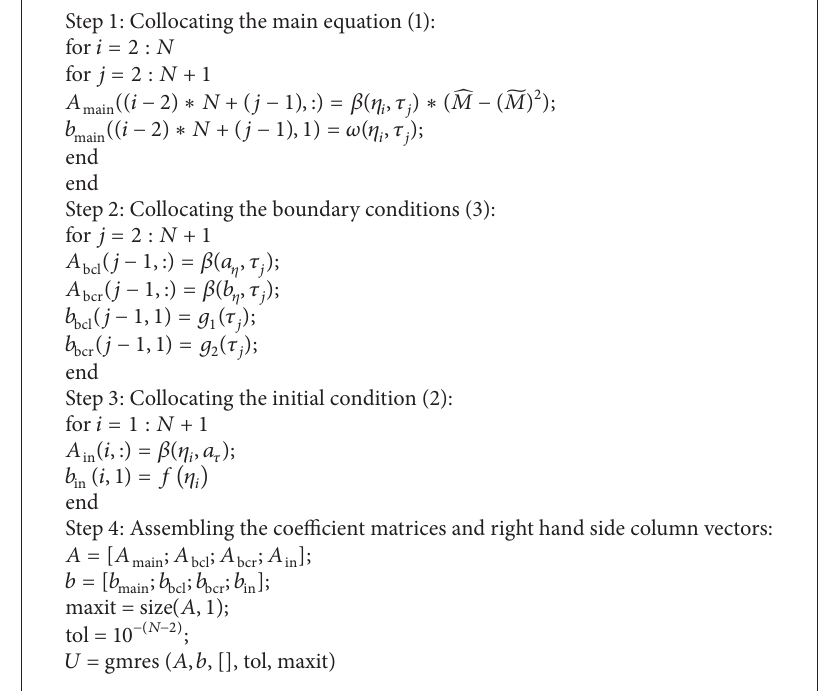
Algorithm 1: Implementation of BCM for solving (1)–(3).